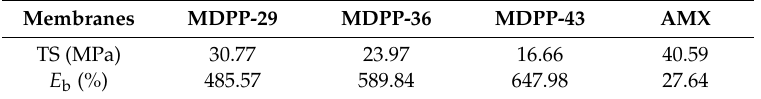
Table 2. Tensile strength and elongation at break of membranes MDPP-29 to MDPP-43.